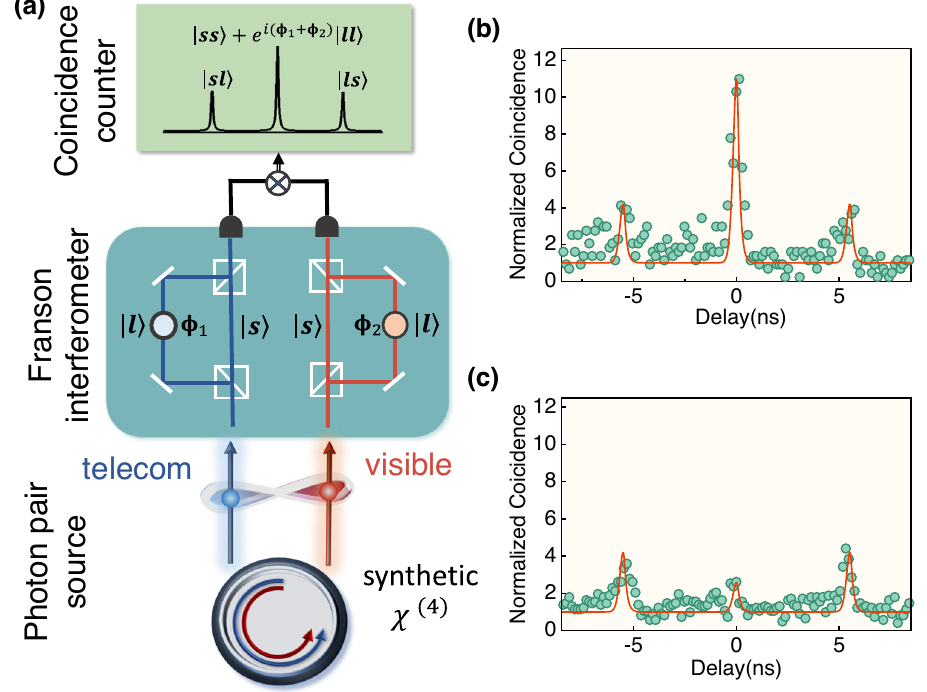
(cid:4) ( ∣ ll ), with the output coincidence depending on the phases of the MZIs ( ϕ 1 + ϕ 2 ). b , c The interference fringes of the Franson interferometer, showing the con- structive and destructive interference, with a peak CAR visibility of 72.7%±3.3%, corresponding S =2.056±0.093 for the Bell inequality